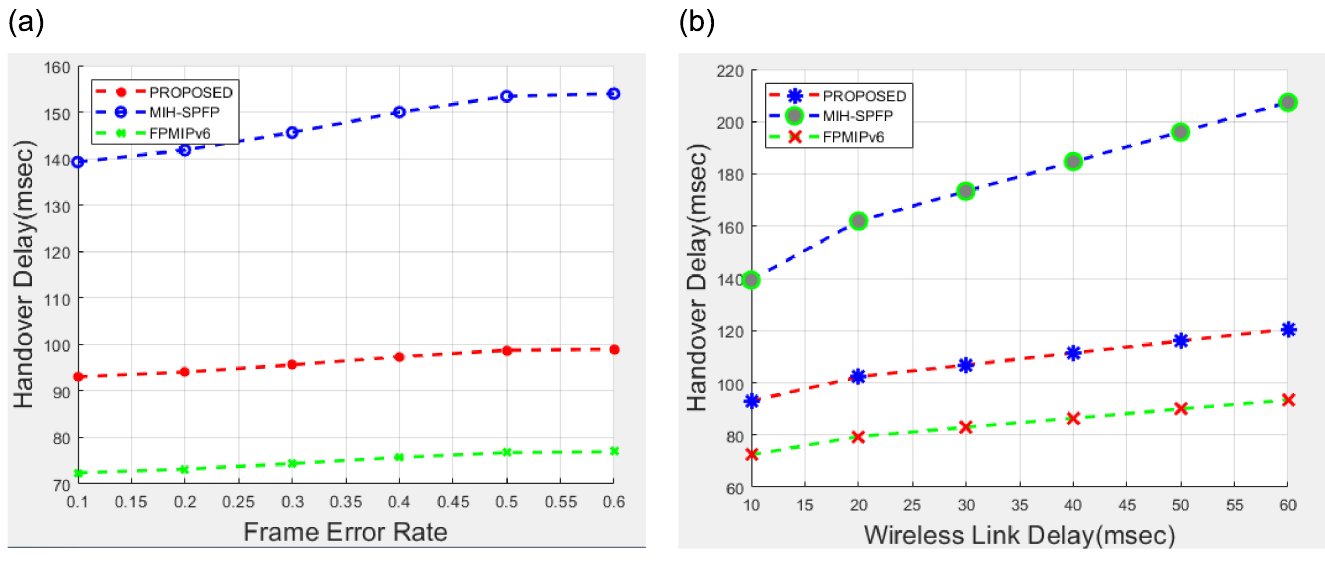
Fig 7. Handover delay